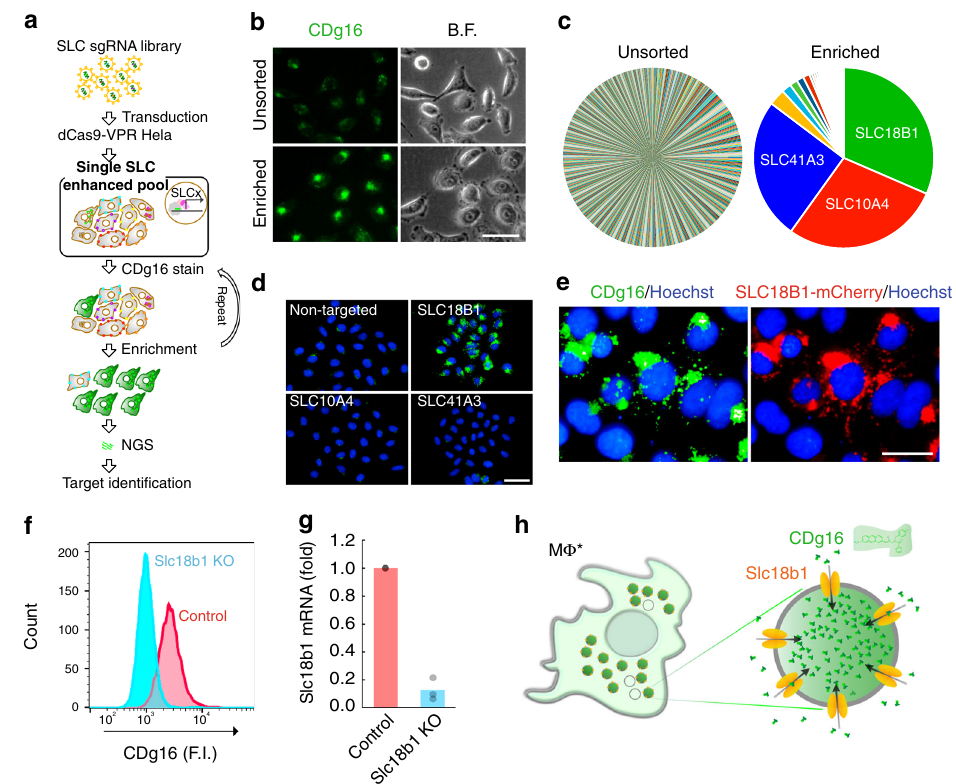
Fig. 3 Slc18b1/SLC18B1-mediated uptake of CDg16. a Schematic of SLC-CRISPRa screening to detect SLC gene(s) for which CDg16 acts as a substrate. b CDg16 fl uorescence and bright- fi eld (B.F.) images of the unsorted SLC-CRISPRa HeLa cells (Unsorted) and the six-round enriched HeLa cells (Enriched). c NGS counts of the top 1000 highly enriched sgRNAs in the unsorted and the six-round enriched populations. The percentages of each sgRNA count to the total count are represented as a pie chart. The targeted genes for the three most enriched sgRNAs are indicated. d Fluorescence images of CDg16 (green) and Hoeschst33342 (blue) of the three independently generated SLC clones and non-targeted sgRNA. Fluorescence images were taken after 1-h incubation with CDg16 (200 nM) and Hoechst33342 (1 µ g/mL) in culture media. e Colocalization of the fl uorescence signals of CDg16 (green) and of mCherry (red) from SLC18B1-mCherry transfected HeLa cells. Scale bars, 50 µ m ( b , d ) or 20 µ m ( e ). f The intracellular fl uorescence intensity of control and Slc18b1-CRISPR knockout Raw264.7 M1 macrophages (Slc18b1 KO). CDg16 (250 nM) was incubated for 1 h to the LPS- (100 ng/mL) and IFN ɣ - (20 ng/mL) pre-treated M1. Flow cytometry was used to measure the intensity of CDg16 fl uorescence. g Slc18b1 mRNA expression in control and Slc18b1 KO cells. h The proposed staining mechanism of CDg16. M φ * activated macrophage, Slc18b1 solute carrier family 18 member